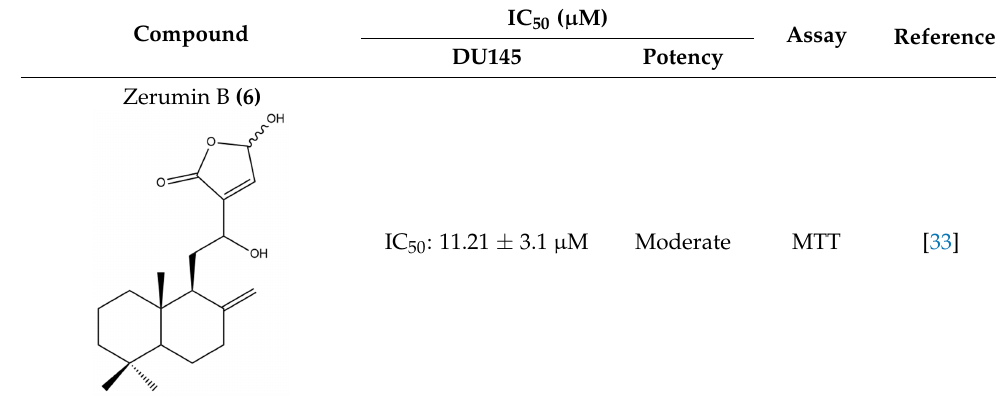
Table 20. Cytotoxic activities of labdane-type diterpenes from the Zingiberaceae against selected prostate cancer cell lines.